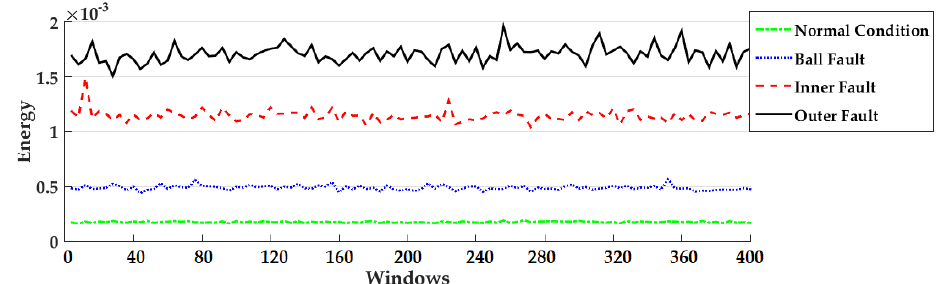
Figure 4. Energy features in normal and anomalous conditions based on the fuzzy orthonormal-ARX adaptive fuzzy logic-structure feedback (PM) observer.